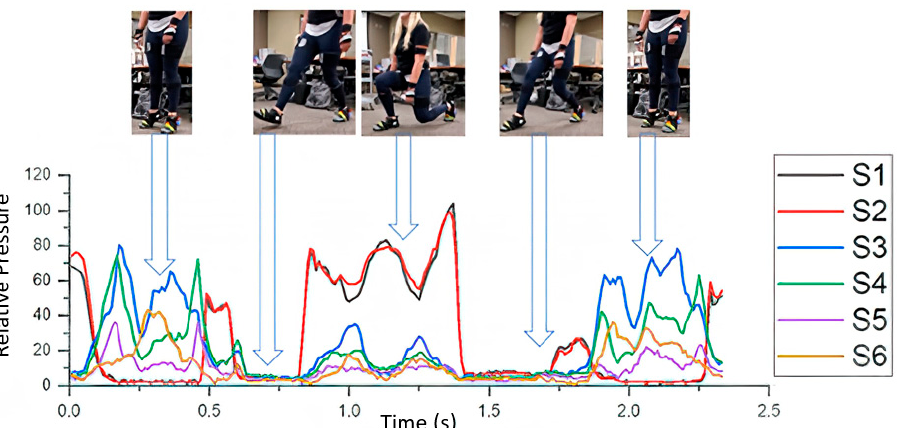
Figure 6. The stoop motion of the experiment with the accompanying sensor readout for the left foot of the